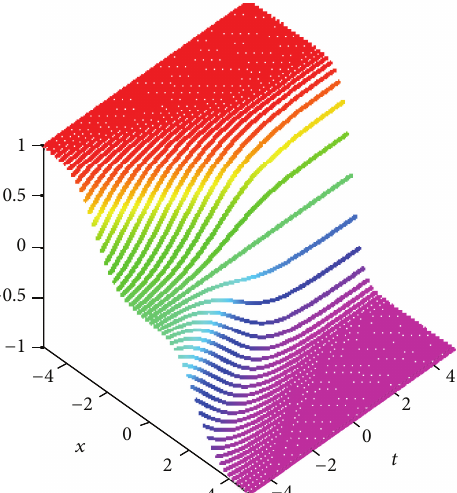
Figure 4: Thespace-timegraph oftheestimated solutionof Burgers’equation by using IMQQIfor 𝑥 ∈ [−5,5] and 𝑡 ∈ [−5, 5] of Experiment 3.